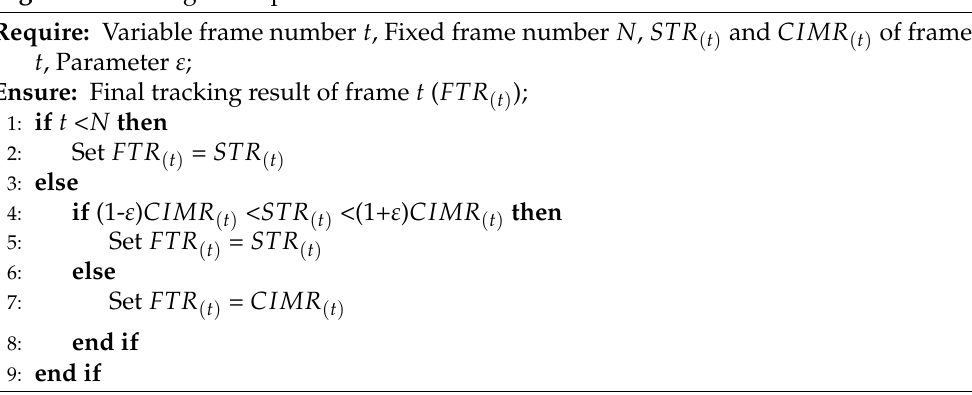
Algorithm 1 The general procedure of ID-CIM.